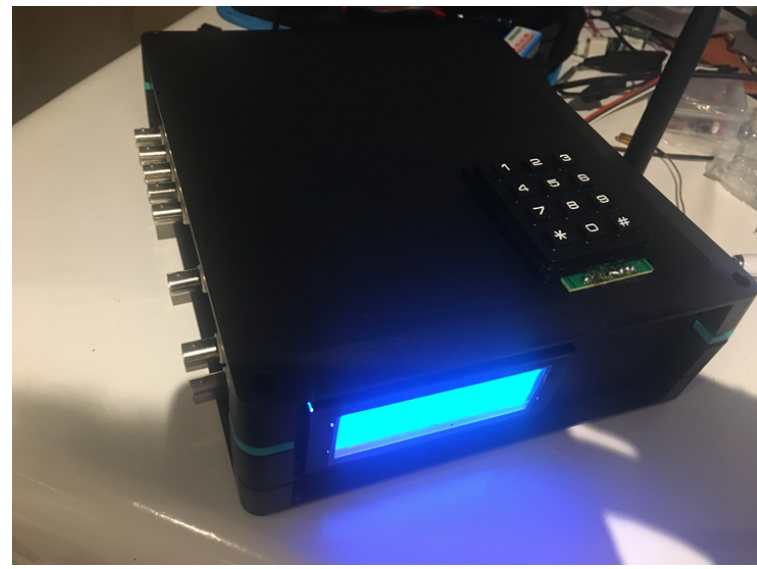
Figure 7. WaterMon Sensor.